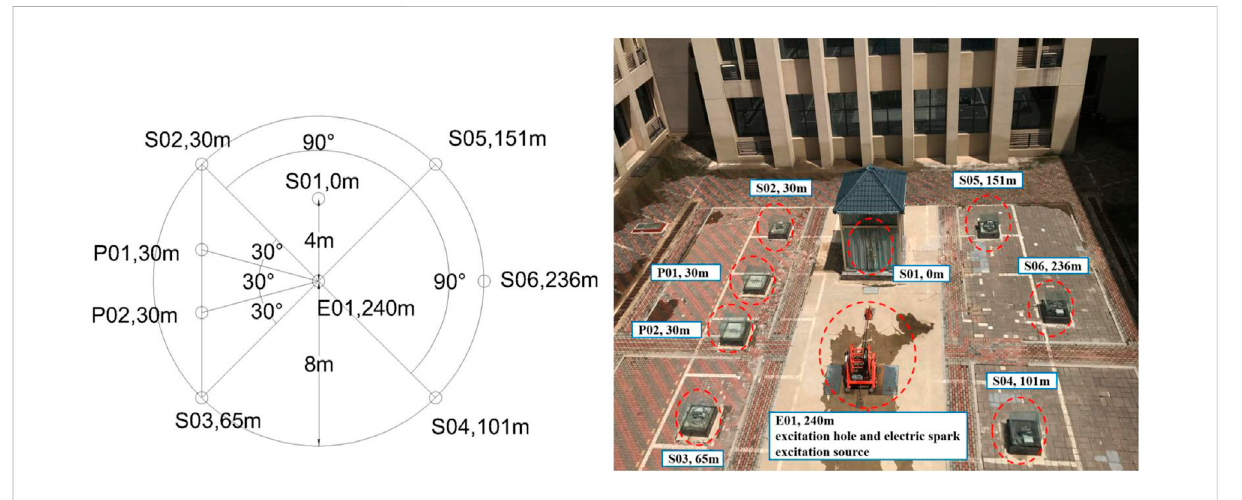
FIGURE 1 Local effect array measurement point